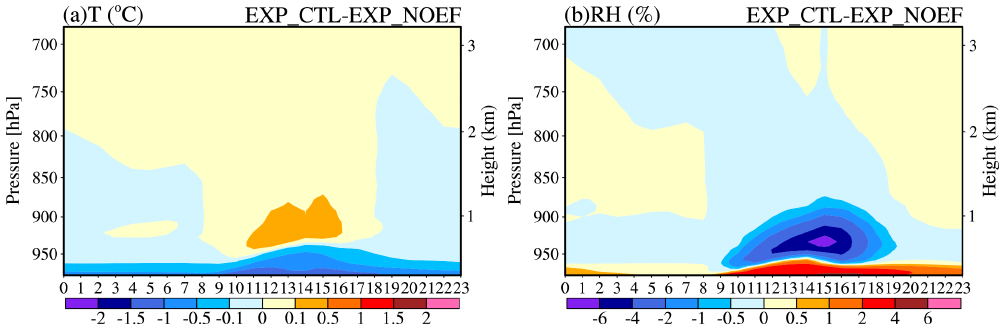
Figure 8. Time–altitude distribution of aerosol-induced diurnal change in (a) temperature ( ◦ C) and (b) RH (%) averaged for the BTH region and the period 10–15 January 2013.